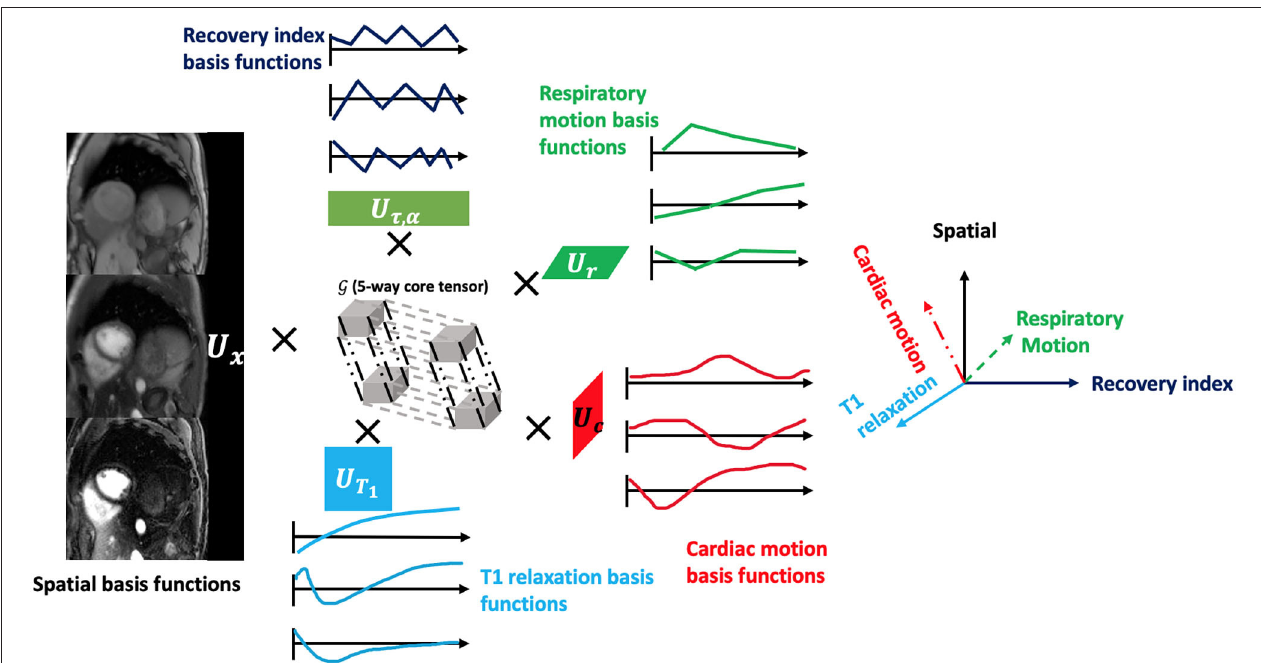
FIGURE 2 | The framework of the low-rank tensor (LRT) imaging model. The underlying image can be represented as a 5-way tensor with one spatial dimension and 4 time dimensions representing 4 dynamic processes: T1 relaxation process, recovery weights with different T2prep-IR duration and flip angles, respiratory motion, and cardiac motion. With the LRT image model, the tensor can be factorized into five factor matrices with much smaller sizes, reducing the degrees of freedom for the LRT recovery